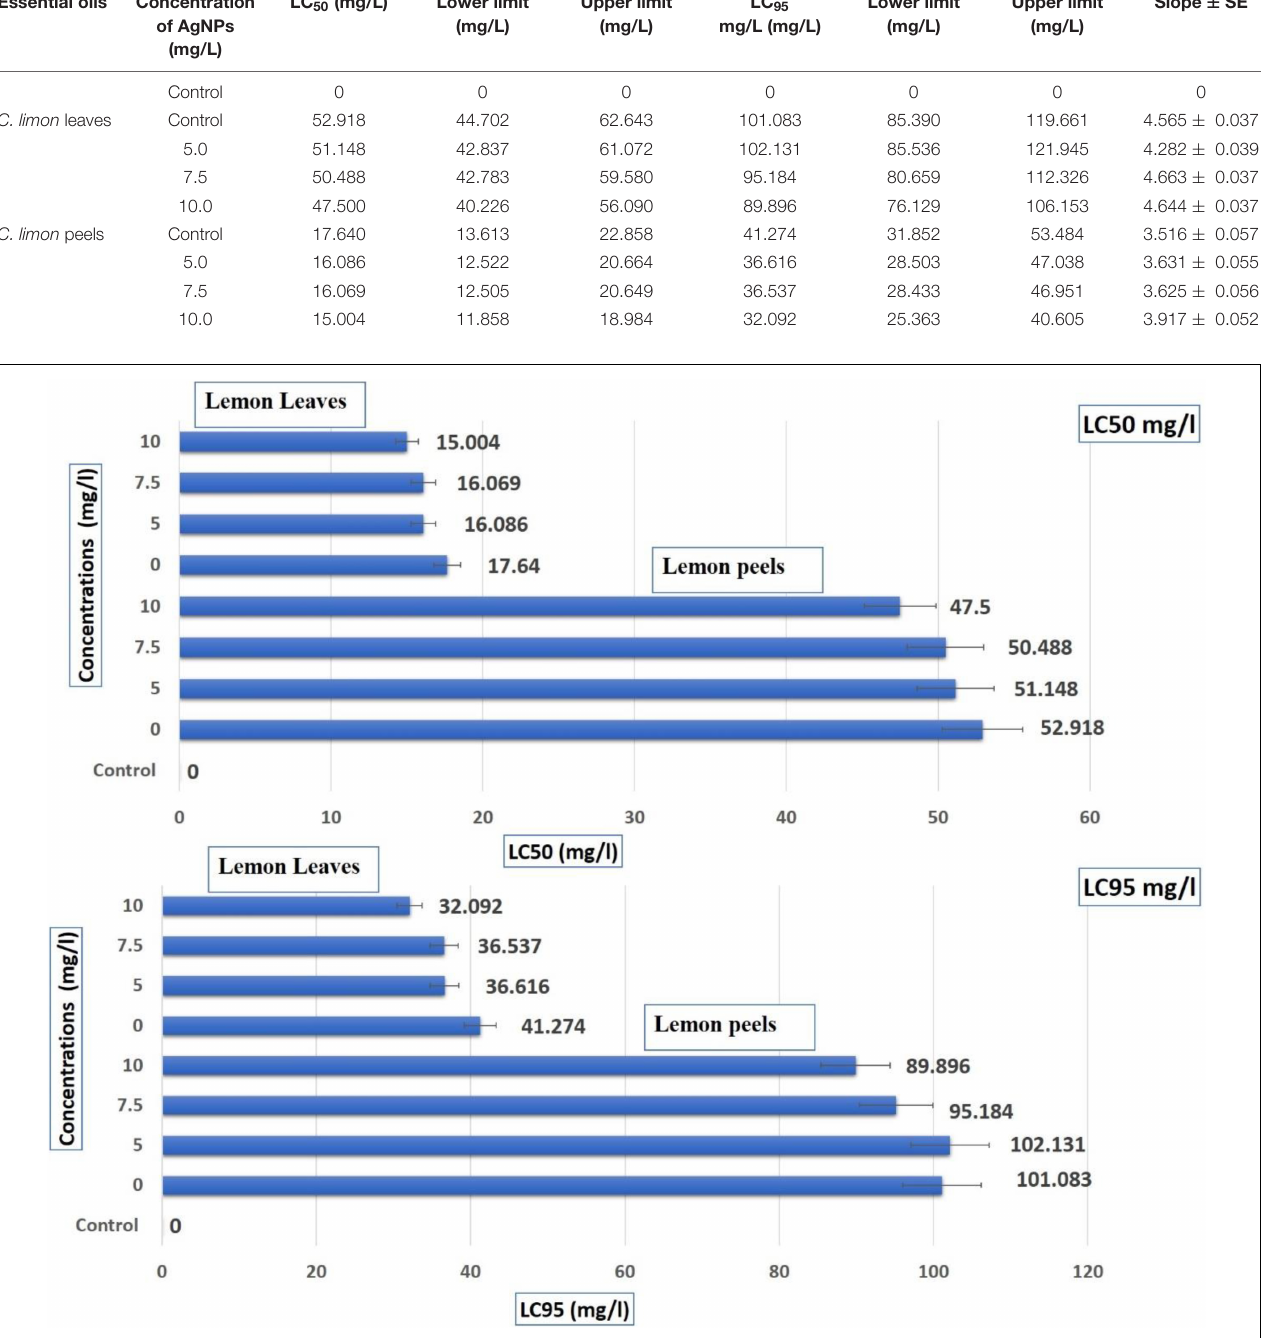
TABLE 6 | Insecticidal activity of C. limon essential oil against S. oryzae . Essential oils